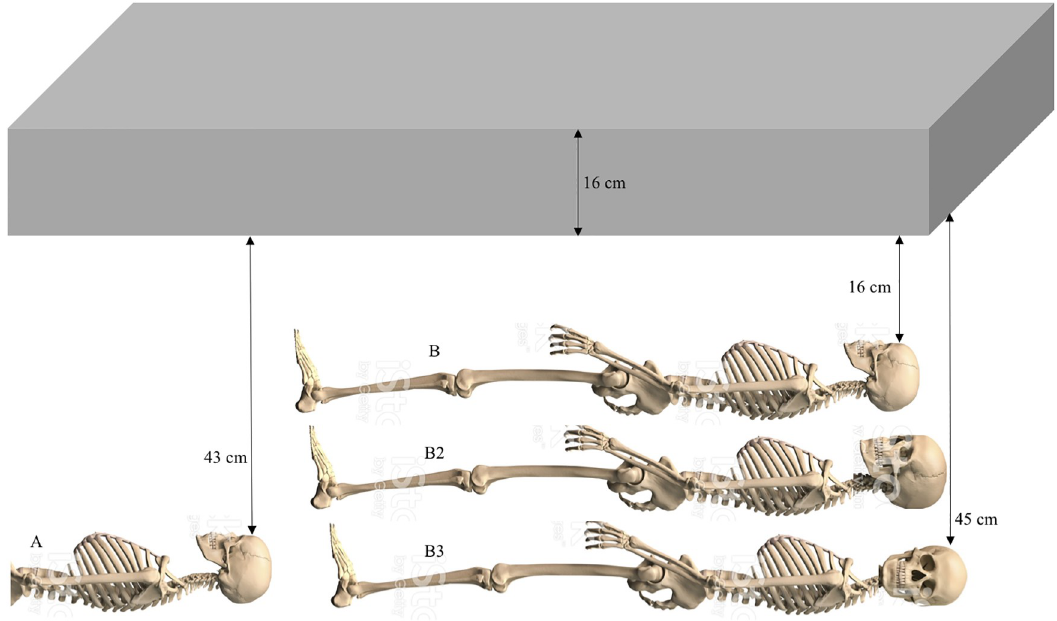
Fig 2. Schematic diagram of the YNH4 burials. See text for